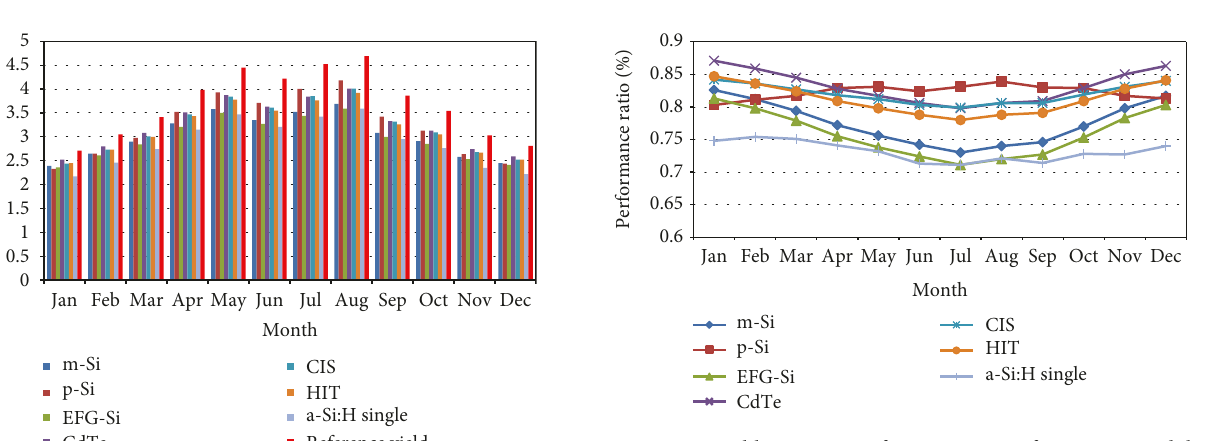
Figure 4: Yearly average energy output, PV array, and system e ffi ciency of seven PV module technologies.